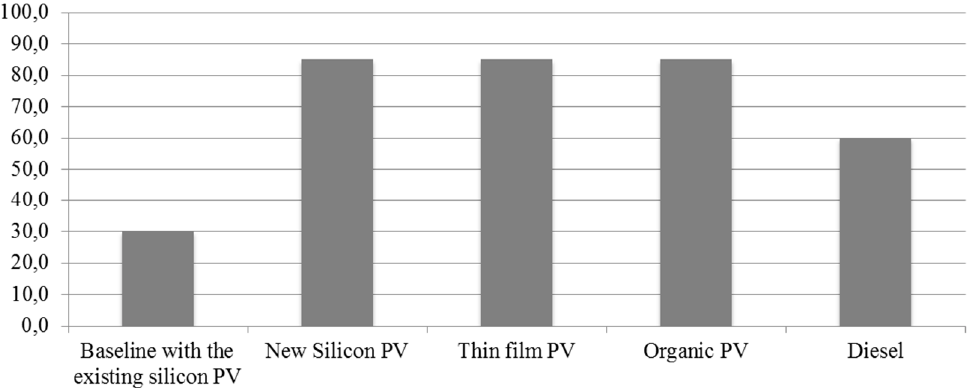
Figure 2. The EE Index (see Table 3), or multicriteria score, of five energy alternatives on overall livelihoods capitals, Las Calabazas, Cuba, 2012.